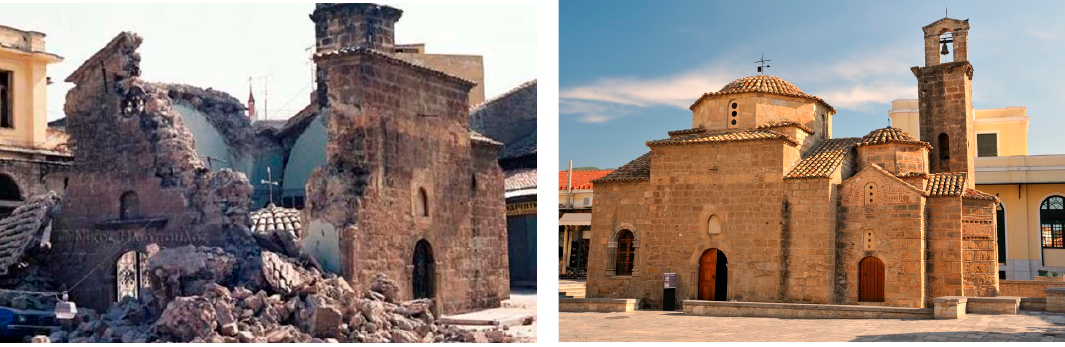
Figure 25. The church of Holy Apostles in the centre of Kalamata.